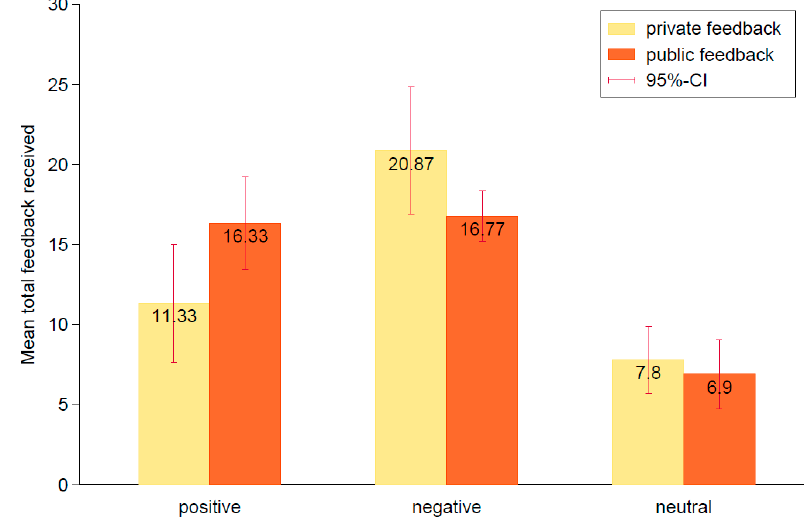
Figure 5. Mean feedback across conditions.